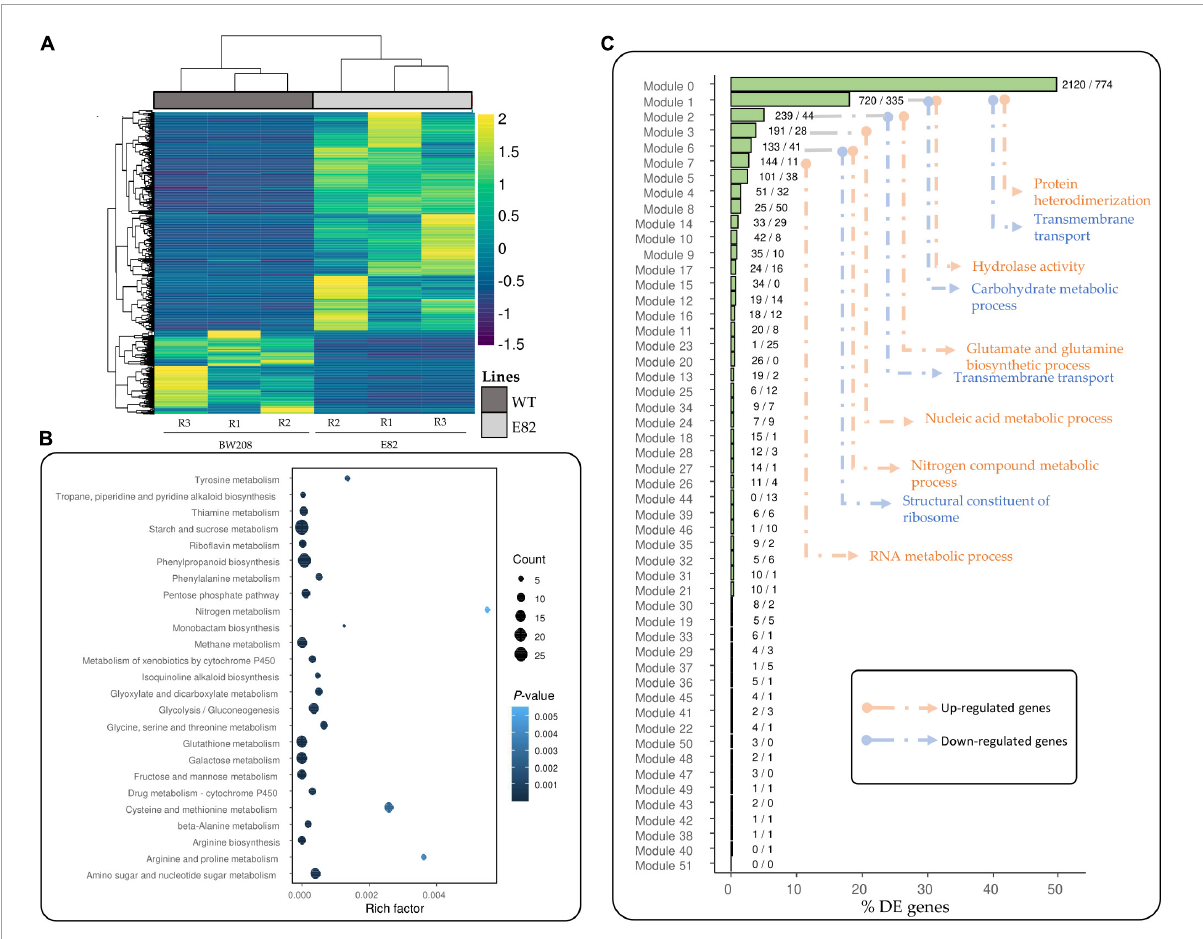
FIGURE7 (A) Heatmaps of Transcript Per Million (TPM) for differentially expressed (DE) genes for the wild type (WT) vs. E82 comparison in leaf tissue. Values are scaled by row (–1.5 to 2). Dendrograms of genes and lines were represented. (B) Kyoto Encyclopedia of Genes and Genomes (KEGG) pathway enrichment analysis for down-regulated genes in E82 leaf tissue against the WT. The rich factor is the division between the number of DE genes annotated and the total number of genes annotated in each pathway. The count value is the number of DE genes annotated in this Kegg Orthology (KO). (C) Percentage of DE genes which belong to each module in the Weighted Gene Co-expression Network Analysis (WGCNA) network for leaf tissue. The label close to the bars indicates the number of up-/down-regulated genes in each module. The most enriched GOs for the set of up- and down-regulated genes in each module were represented following the arrows. R: